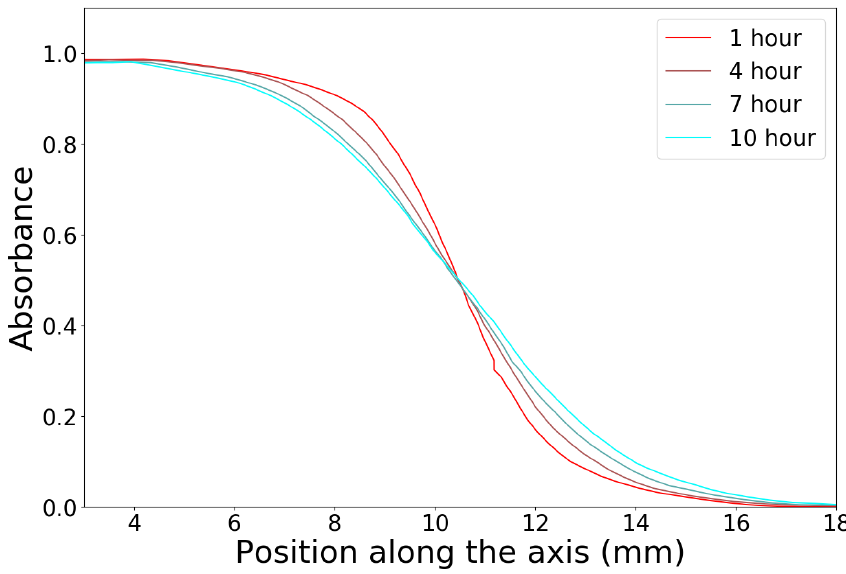
Figure 4. Normalized time-dependent absorbance-position profiles for PVA-B gels. Adapted from